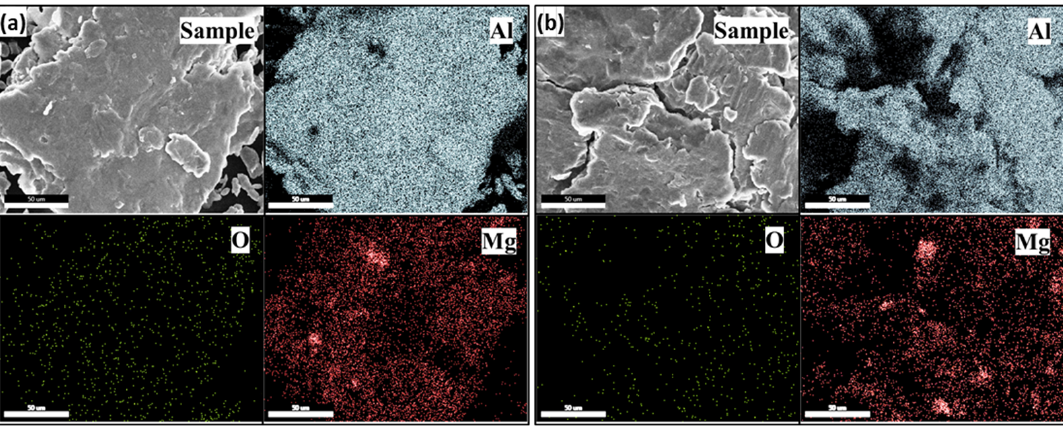
Figure 7. Plot showing SEM-EDX elemental mapping for ( a ) 4 h and ( b ) 6 h cryomilled Al-3Mg powder samples.